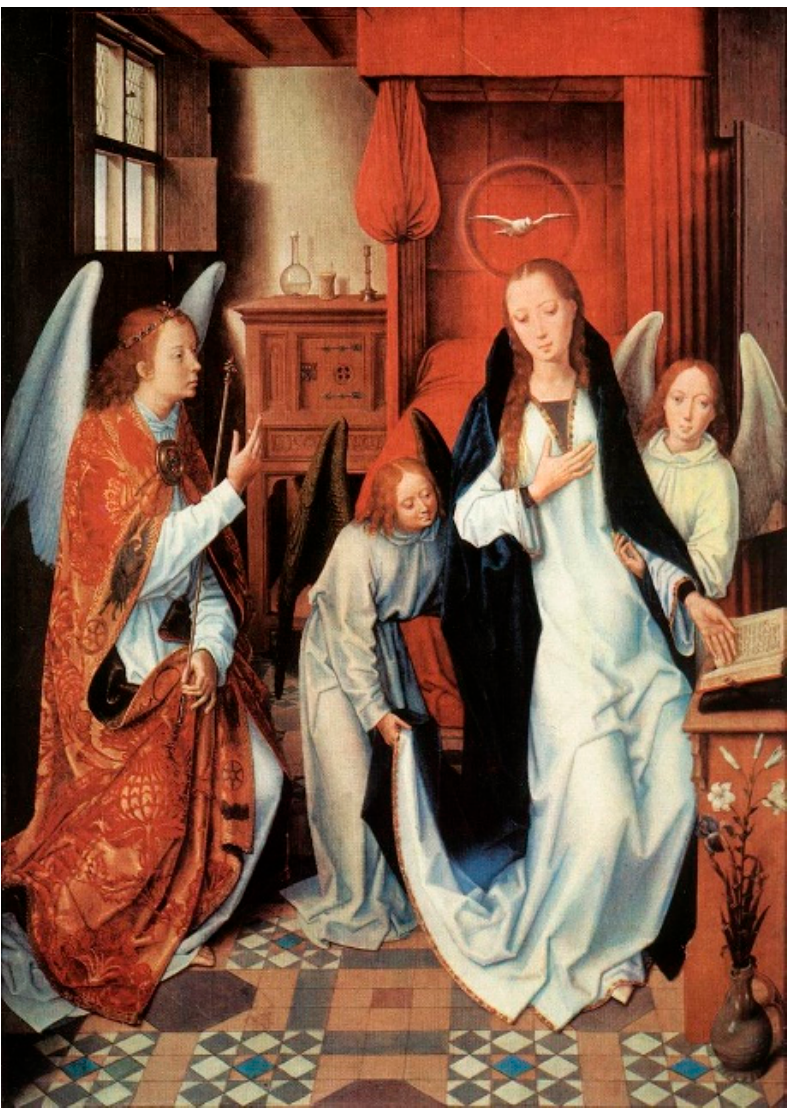
Figure 14. Hans Memling, The Annunciation with angelic attendants , 1482. The Metropolitan Museum of Art, New York.